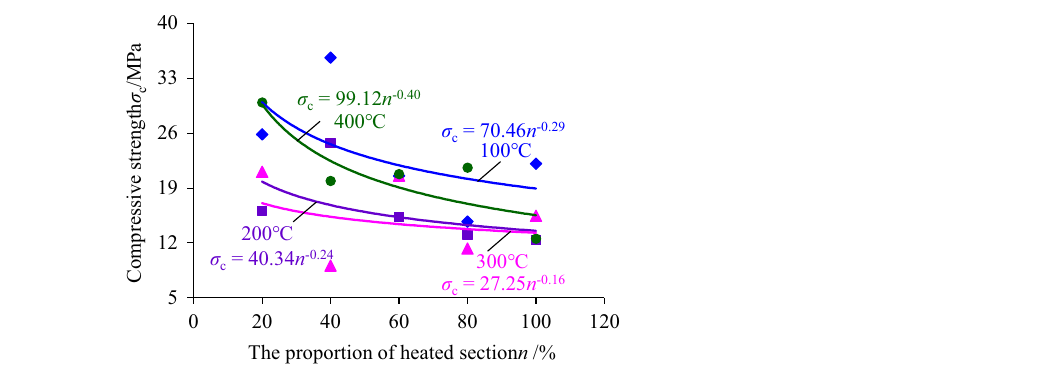
σ c = 70.46 n -0.29